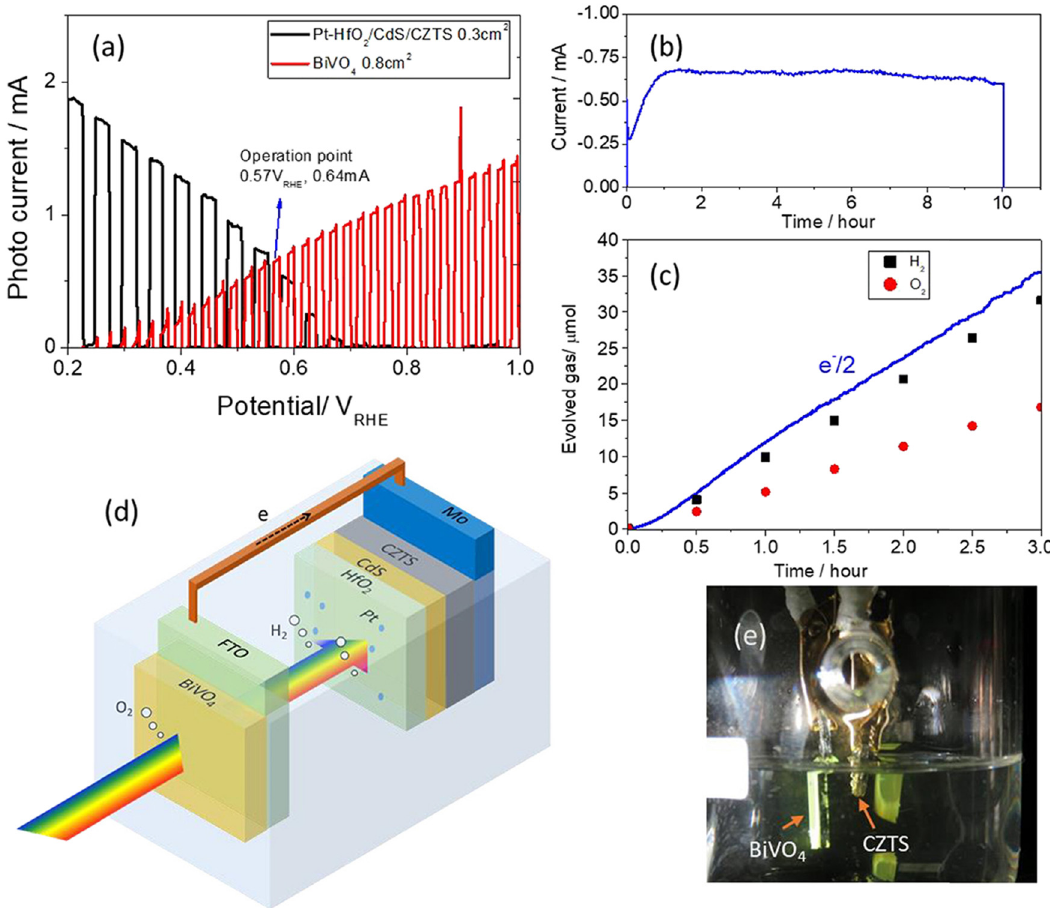
Figure 12: ( a ) J – V curves of a Pt/HfO 2 /CdS/Cu 2 ZnSnS 4 photocathode and a BiVO 4 photoanode under solar simulated AM 1.5G irradiation in a 0.2 mol · dm − 3 Na 2 HPO 4 /NaH 2 PO 4 solution ( pH 6.5 ) . ( b ) Typical unbiased photocurrent generated from a Pt/HfO 2 /CdS/Cu 2 ZnSnS 4 – BiVO 4 tandem device over a 10 h durability test. ( c ) Time course curves of H 2 and O 2 evolution and e − /2. ( d ) A picture and ( e ) a photo of the device. Reprinted with permission from ref. [ 77 ] . ©2018 American Chemical